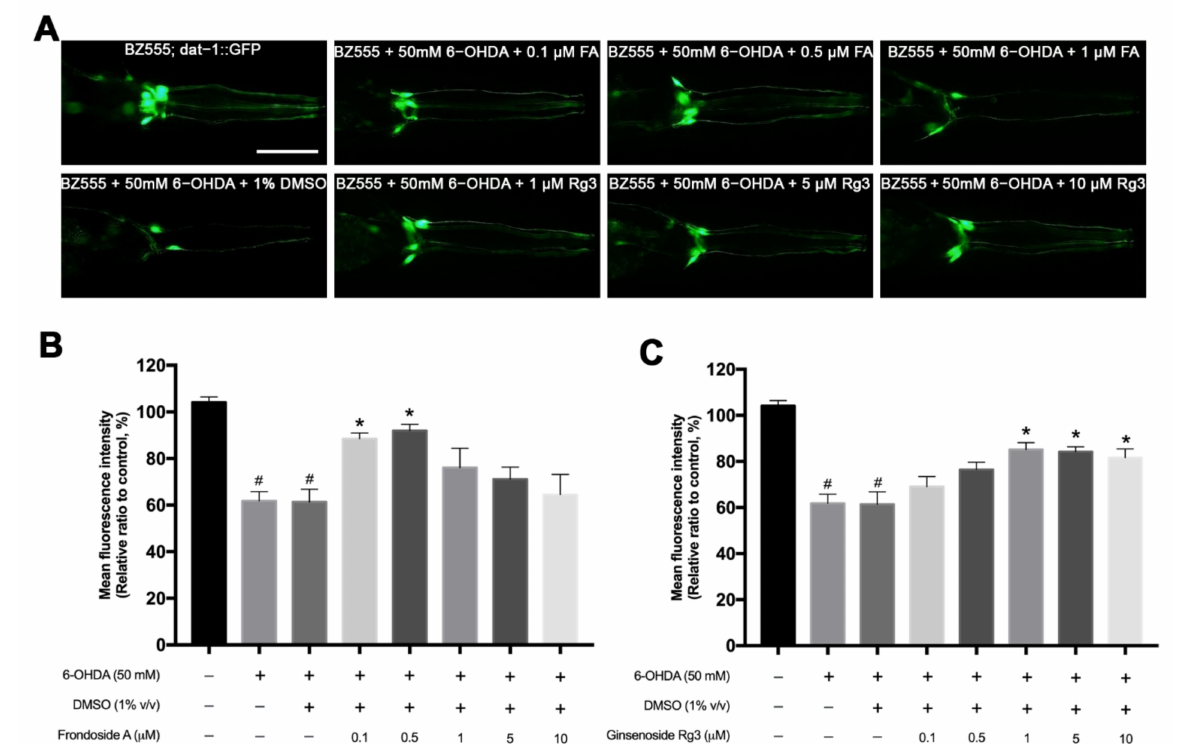
Figure 3. Effects of FA and Rg3 on restoration of 6-OHDA-induced DAergic neurodegeneration in C. elegans BZ555 strain. ( A ) GFP expression pattern in DAergic neurons of normal BZ555 strain, BZ555 exposed to 50 mM 6-OHDA, and BZ555 exposed to 50 mM 6-OHDA and treated with FA (0.1, 0.5, 1 µ M) or Rg3 (1, 5, 10 µ M). Scale bar, 50 µ m. ( B , C ) Graphical representation for MFI of GFP expression in DAergic neurons treated with FA ( B ) and Rg3 ( C ) as measured by using ImageJ software. The hash (#) indicates a significant difference between 6-OHDA-induced and uninduced worms ( p < 0.05). The asterisk (*) indicates a significant difference between the 6-OHDA-induced control worms and the FA/6-OHDA- or Rg3/6-OHDA-treated worms ( p < 0.05). The experiment was performed independently at least three times (number of worms = 40–50 animals/group per